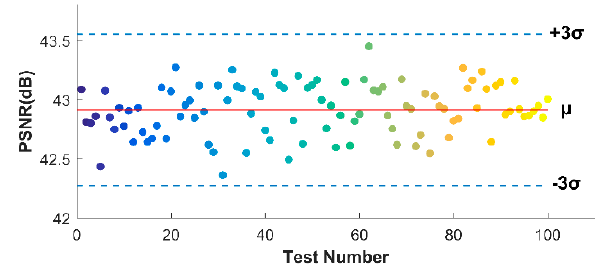
Figure 19. Distribution of 100 orthogonal matching pursuit (OMP) runs based on 3 σ criterion of reliability theory in frequency domain, using 20 MHz SR experimental through-holes data when CR is 50%.